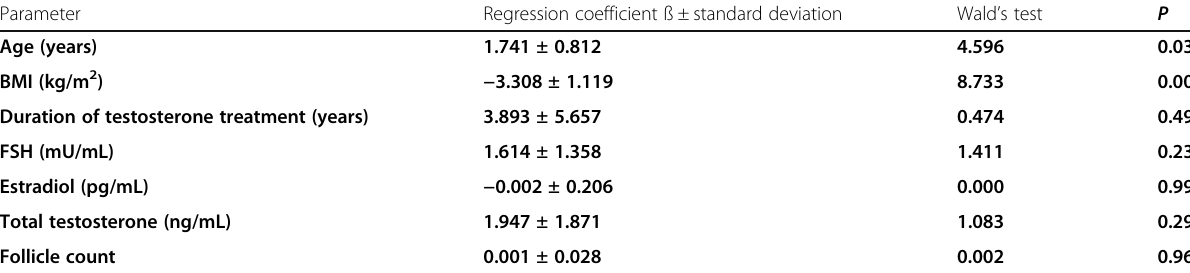
Table 3 Parameters associated with frequency of vital cells (FACS analysis): results of a generalized linear model